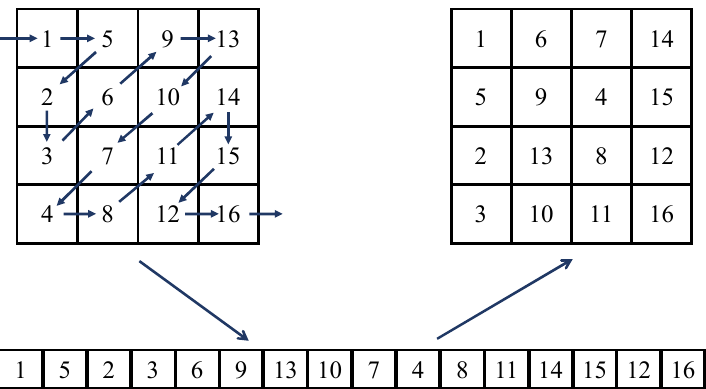
Figure 4. Standard Zigzag transformation for the 4 × 4 matrix.